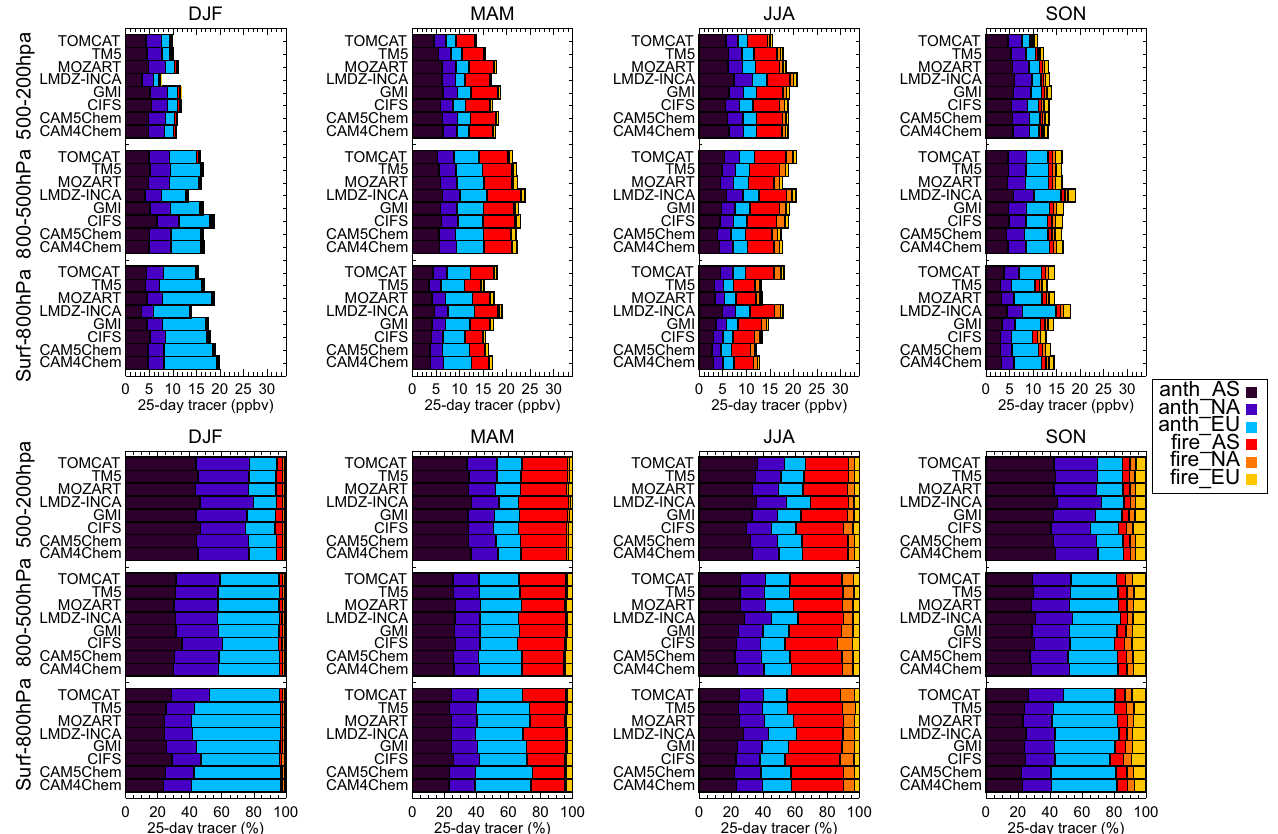
Figure 14. Seasonal mean 2008 regional 25-day fixed-loss anthropogenic and biomass burning regional tracers averaged over three different altitude bands at latitudes north of 66 ◦ N. Contributions shown as absolute concentrations (top) and as a percent of the total CO tracer (bottom; AS–Asian tracer, NA–North American tracer, EU–European tracer).